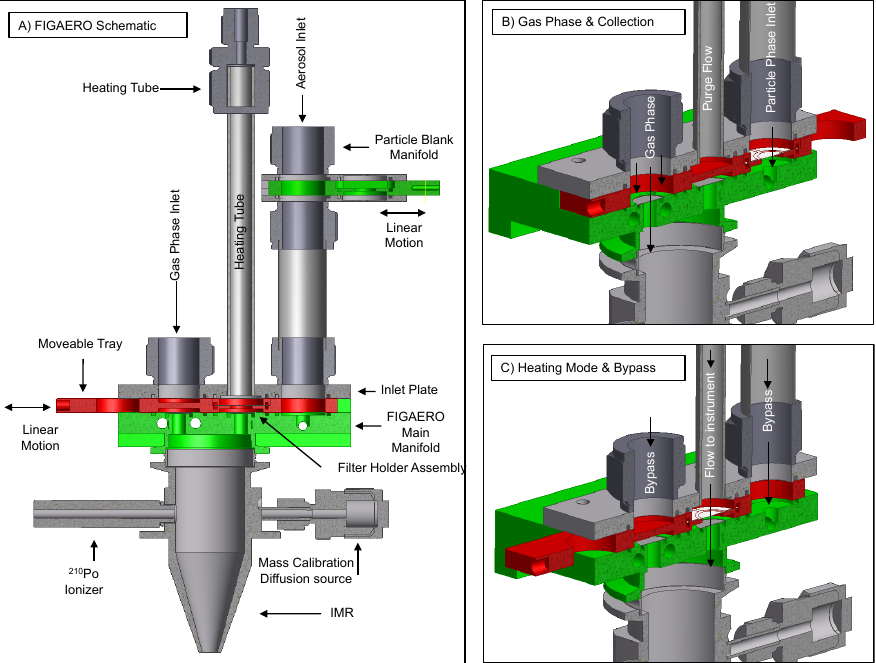
Fig. 1. FIGAERO Schematics. (A) FIGAERO section view. The main FIGAERO manifold (green), made entirely from Teflon, provides inlet and outlet connections for sampling pumps and delivery of gases to the CIMS. The HRTOF-CIMS ionization region is shown for reference below the green manifold. The moveable tray (red), also Teflon, acts as the main FIGAERO valve, and carries the PTFE filter between collection and desorption stages. The moveable tray simultaneously switches the sample flow entering the instrument between the two dedicated exit ports, one exclusively for gases, one exclusively for thermal desorptions. The inlet plate assembly (grey on top of red section) provides the interface between the FIGAERO manifold and the ambient sampling inlets. The gas analysis port is a 19mm Swagelok compression fitting; the particle collection port is a 25mm compression fitting. (B) A perspective section view of the FIGAERO in gas measurement and particle collection mode. The desorption orifice is blocked by the moveable tray. Black arrows show the flow paths, both into the instrument and across the filter. The gas phase flow rate is ∼ 22sLpm, only 2sLpm of which enter the instrument. The particle collection inlet has a flow rate of up to 30sLpm. (C) A perspective section view of the FIGAERO in particle analysis mode. The gas sampling orifice is blocked by the moveable tray, and the filter has been moved to the thermal desorption region of the manifold where 2sLpm of UHP N 2 are delivered across the filter. This N 2 stream is programmatically heated to desorb the components from the filter. The resulting vapors are sampled through a dedicated orifice into the mass